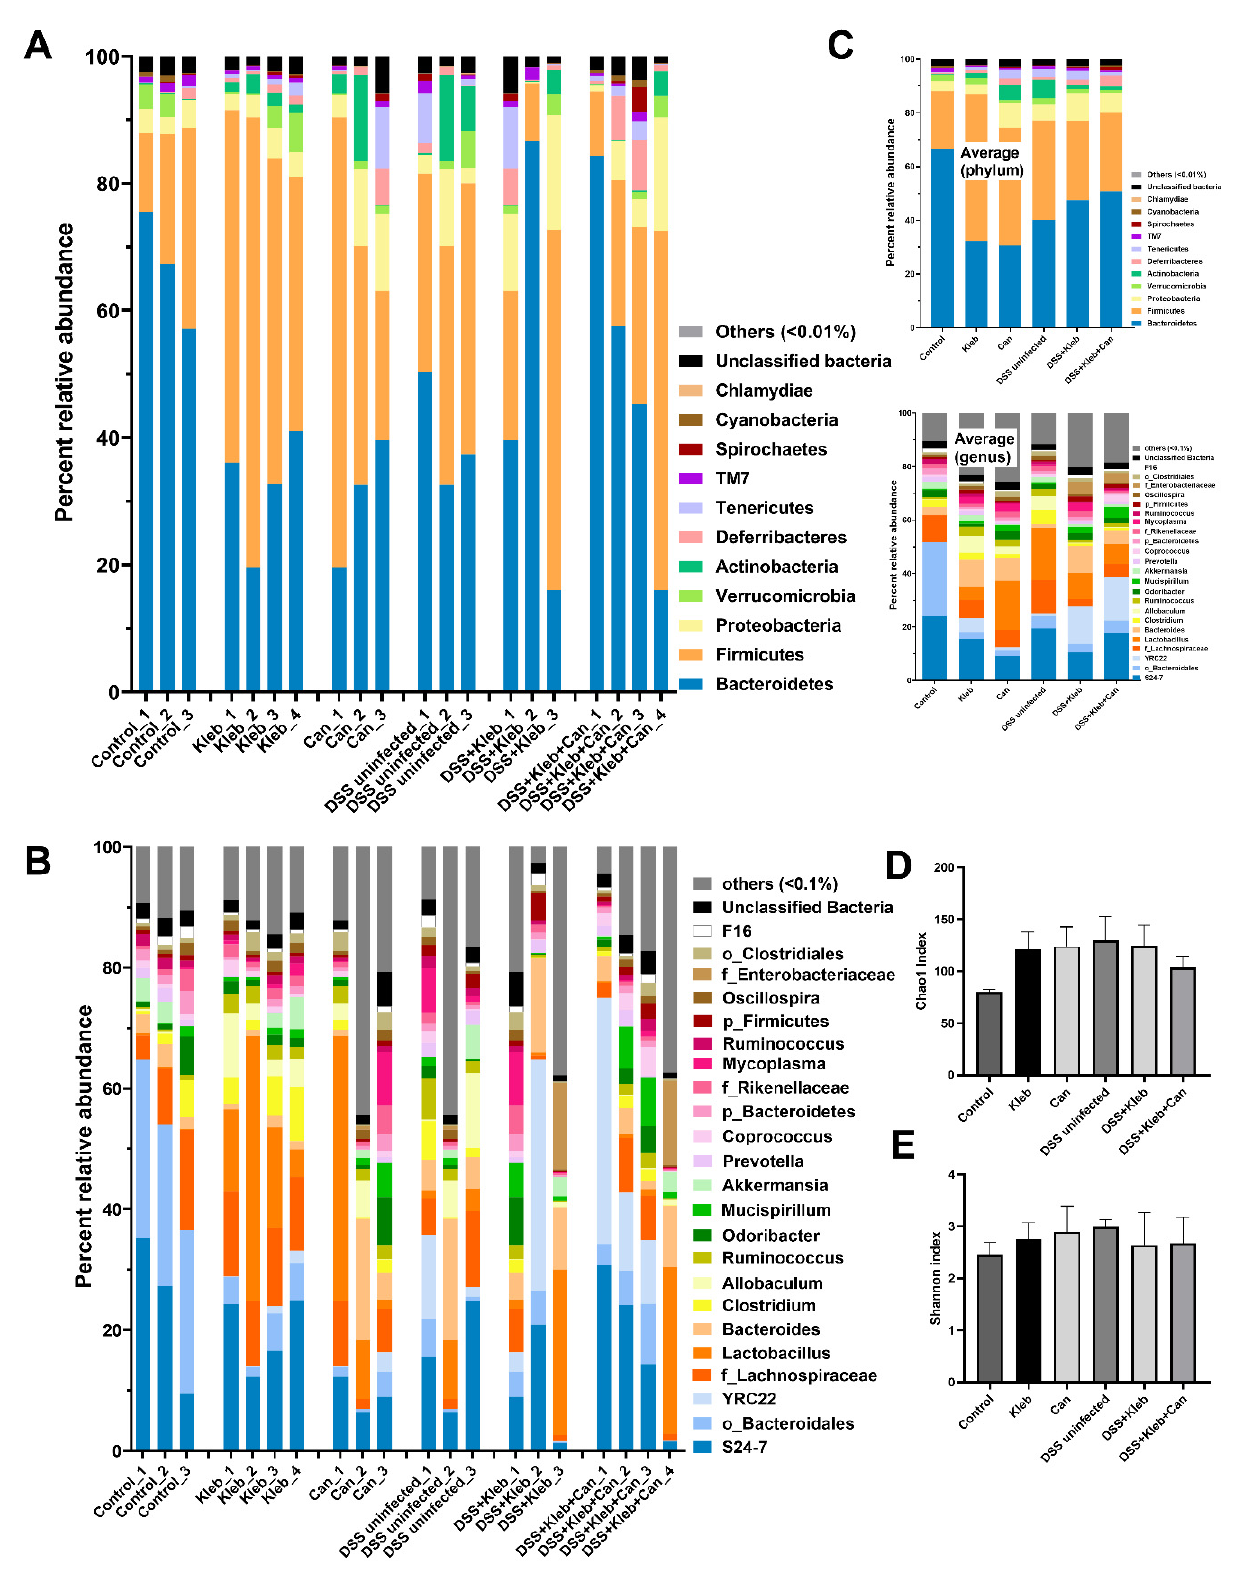
Figure 4. The characteristics of mice after daily gavage with phosphate buffer solution (control), K. pneumoniae (Kleb), or C. albicans (Can) with or without dextran sulfate solution (DSS) as indicated by the abundance of fecal bacteria in phylum and genus levels ( A , B ) with the average values ( C ), and the bacterial diversity index (Chao1 and Shannon index) ( D , E ). (n = 3–4/group)